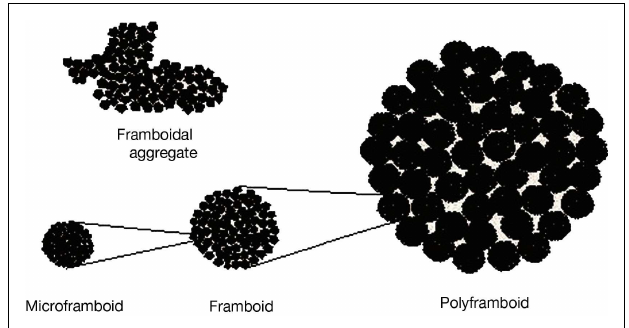
FIGURE 5 |Three size-scales observed in framboids (Adapted from Sawlowicz, 2000 with permission, see text). As a contrast, the top left shows a framboidal aggregate without sufficient surface minimizing